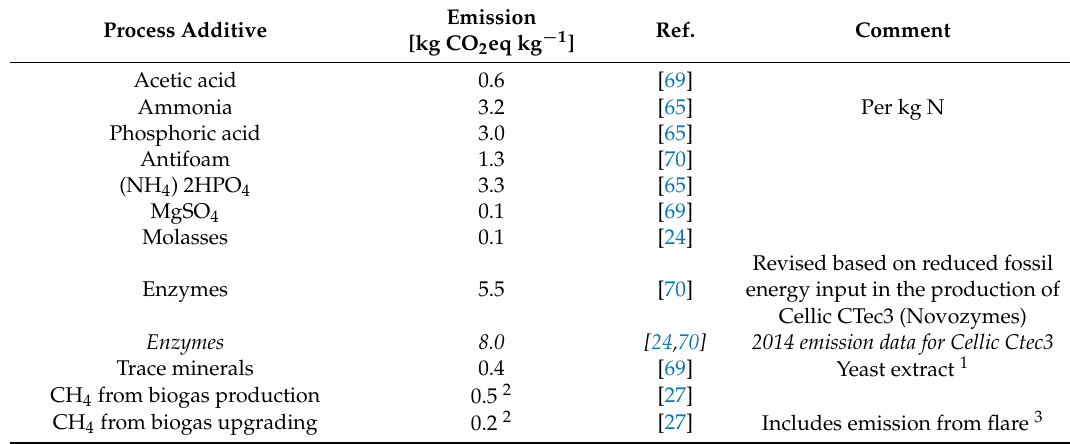
Table A17. Emissions from biofuel production: additives and methane losses in biofuel production. Values in italics are alternative values used in sensitivity analysis. All other values were used in the base